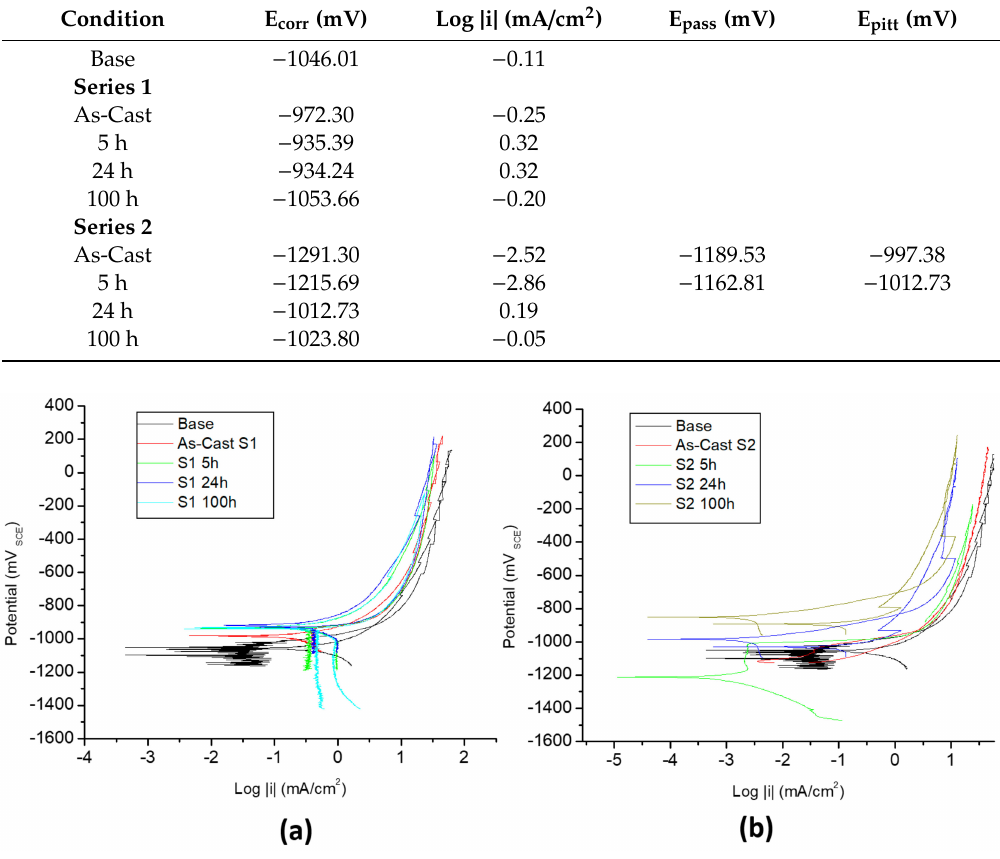
Figure 7. Polarization curves of the AlMgZn alloys ( a ) series 1 ( b ) series